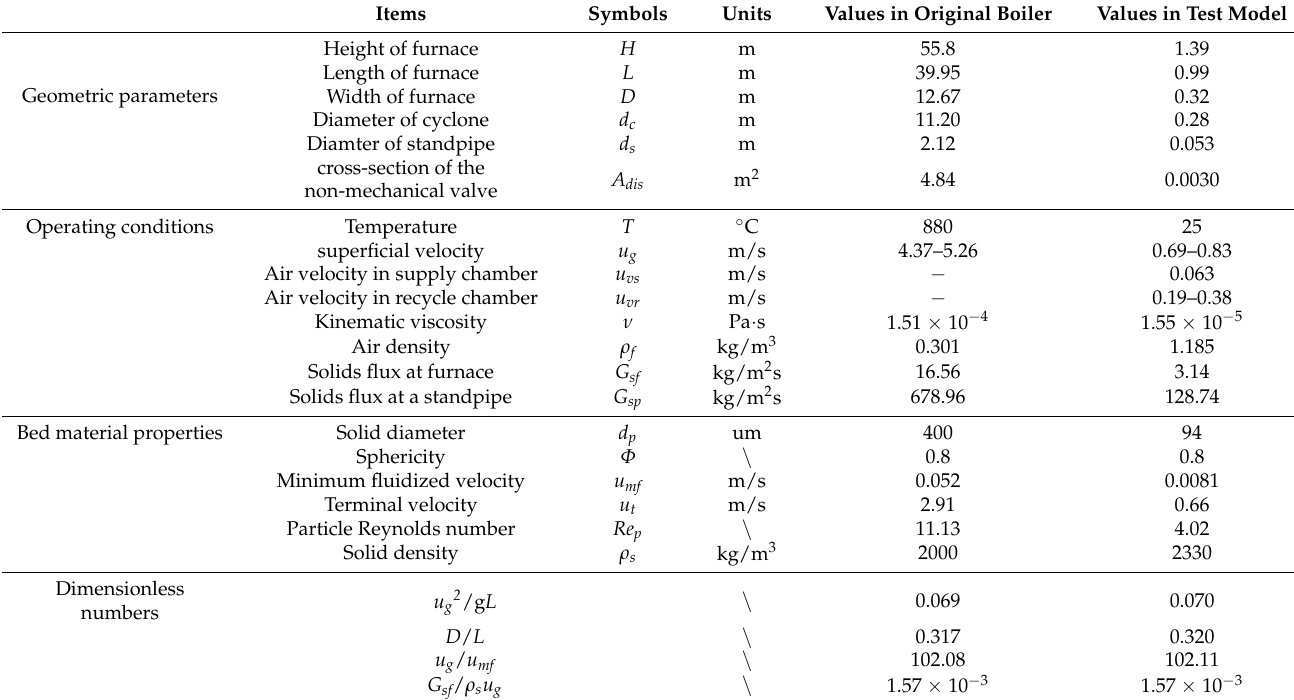
Table 1. Scaling parameters of original boiler and cold